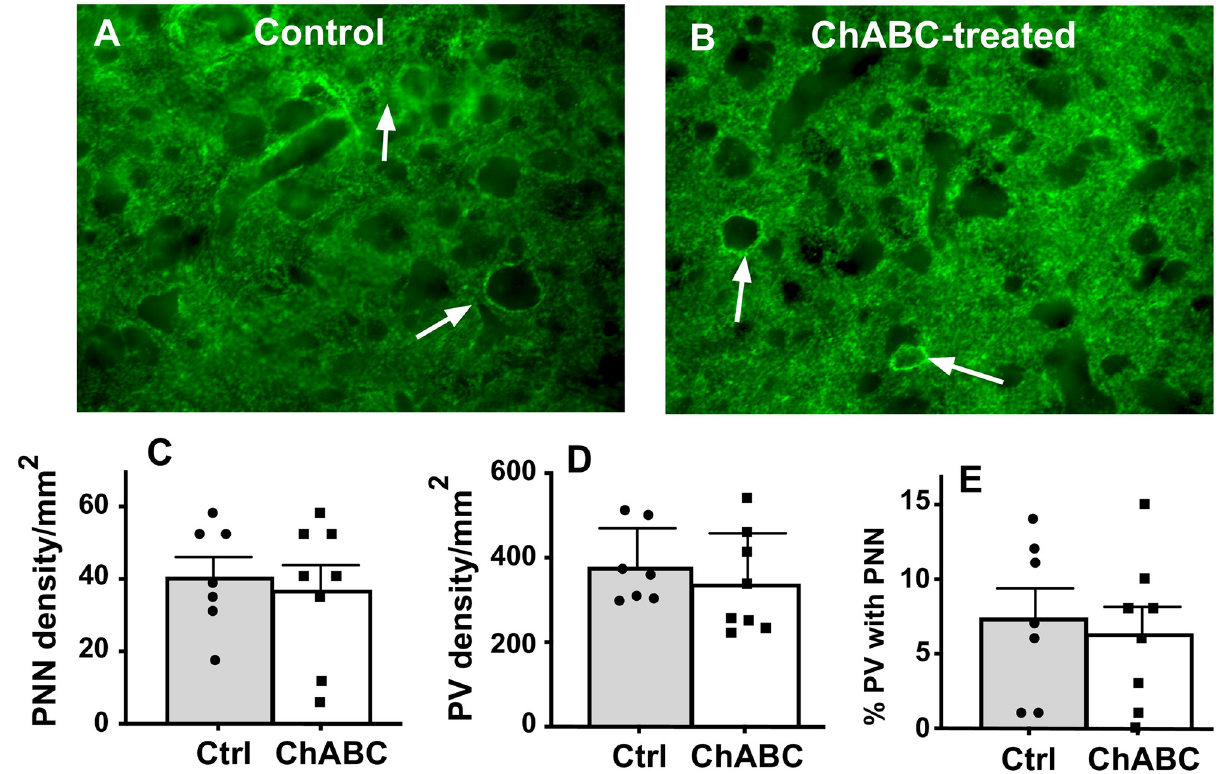
Fig 13. The density of PNN in HVC is no longer decreased 4 months after treatment with ChABC. Panels A and B present examples of photomicrographs illustrating the presence of PNN in the HVC of a Ctrl (A) and a ChABC-treated (B) male. Panels C to E illustrate quantification of the mean density of PNN (C), PV (D), and percentage of PV surrounded by PNN (% PV with PNN; E) in HVC, of Ctrl and ChABC-treated male canaries 4 months after the surgery. At that time no significant difference between groups could be